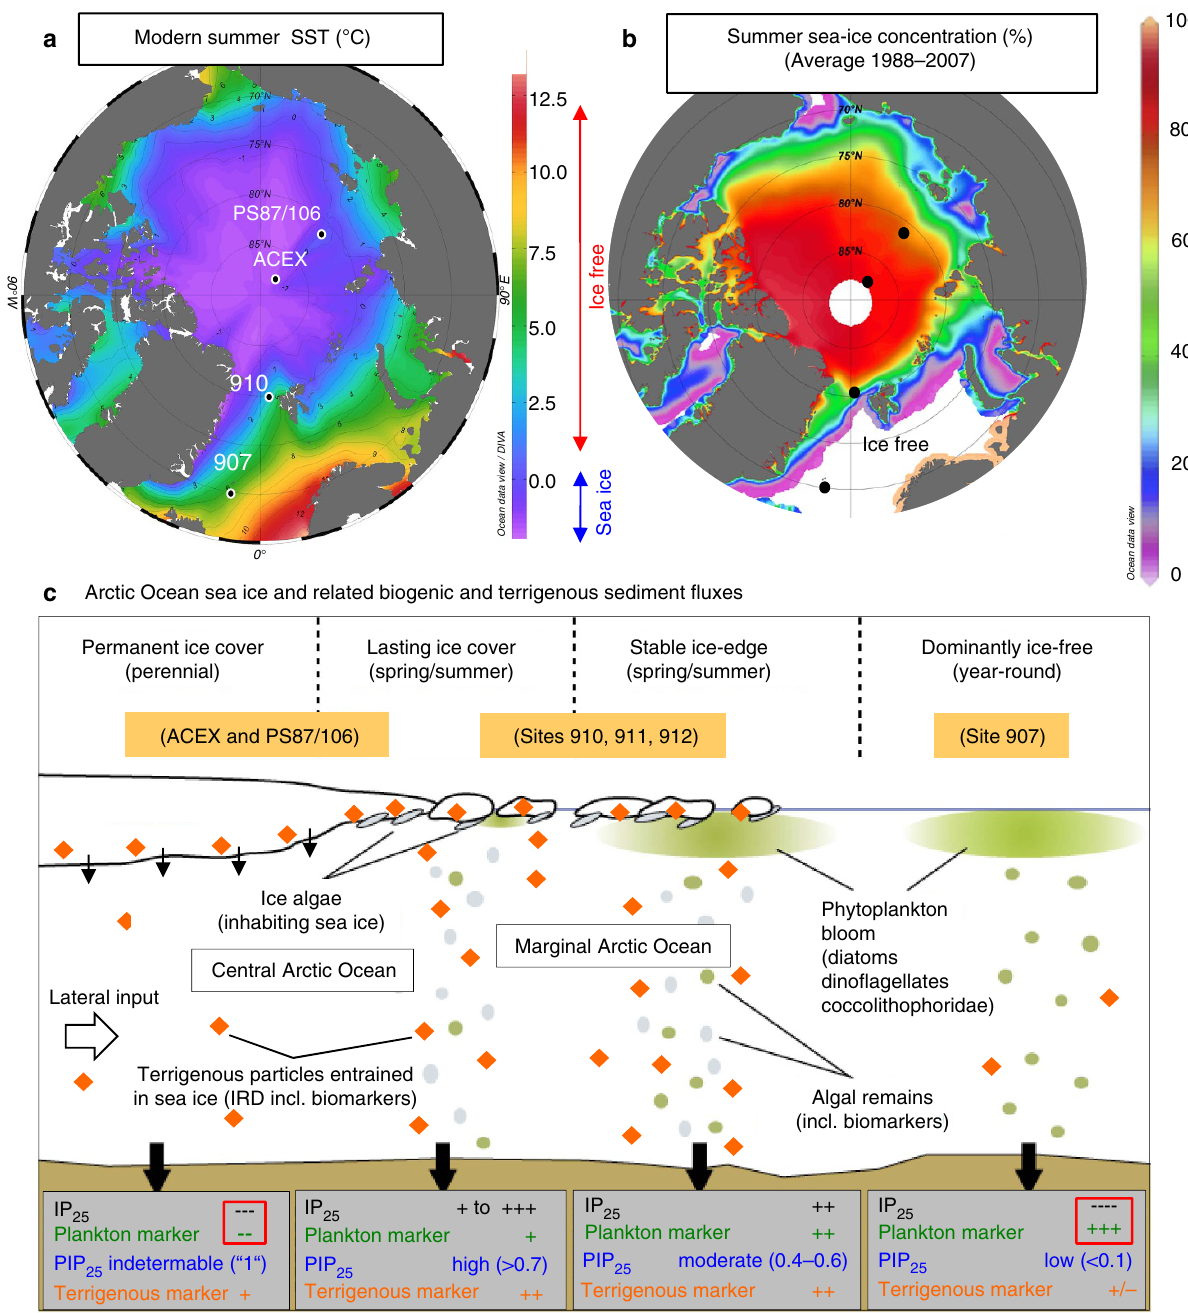
Figure 1 | Modern Arctic Ocean SST and sea-ice conditions. ( a ) Map of modern August SST with locations of ODP Site 907, ODP Site 910 and IODP Expedition 302 (ACEX) Site, as well as Core PS87/106 (August SSTdata—average of 1955–2012—from World Ocean Atlas; http://odv.awi.de/en/data/ ocean/world_ocean_atlas_2013/). ( b ) Map of summer sea-ice concentration—average of 1988–2007—with locations of studied sites (black dots); data source: http://nsidc.org. Maps a and b produced with Ocean Data View software (source: http://odv.awi.de/). ( c ) Generalized scheme illustrating (1) sea surface conditions and respective (spring/summer) productivities of ice algae and phytoplankton, and (2) sedimentary contents of IP 25 ,